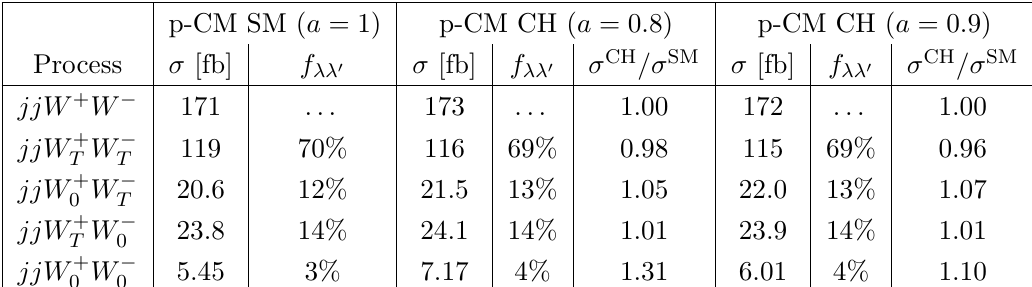
Table 1. Generator-level cross section [fb] for the unpolarized, EW process pp ! jjW + LO, for the SM limit ( a = 1 : 0) and two benchmark Composite Higgs scenarios a = 0 : 8 and a = 0 : 9, as well as the same information for various ( (cid:21); (cid:21) 0 ) helicity con(cid:12)gurations de(cid:12)ned in the parton c.m. frame (p-CM) with their polarization fraction f (cid:21)(cid:21) 0 [%].